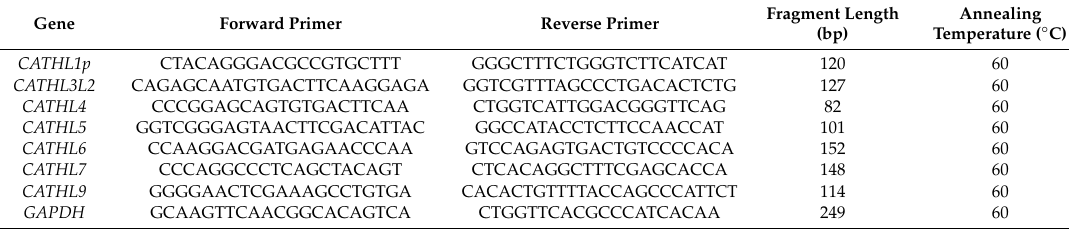
Table 1. Primer sequences used for real-time PCR